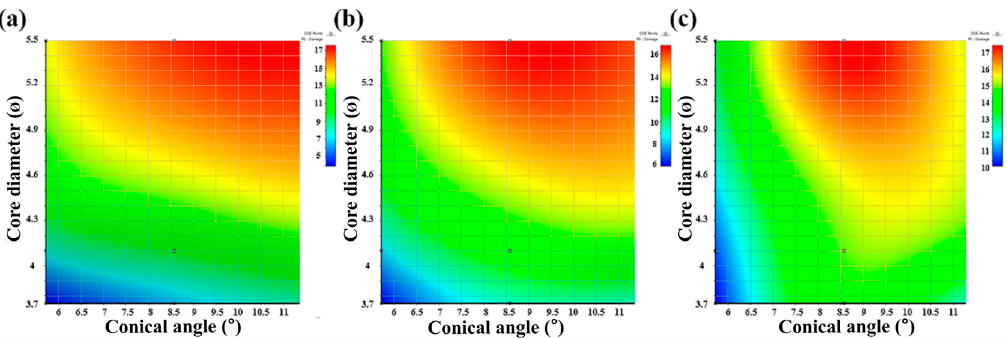
Figure 14. 2D response surface plot of degree of damage with respect to the variables of the pedicle screw and density ( a ) grade 10, ( b ) medium density of grade 10 and 20, and ( c ) grade 20.